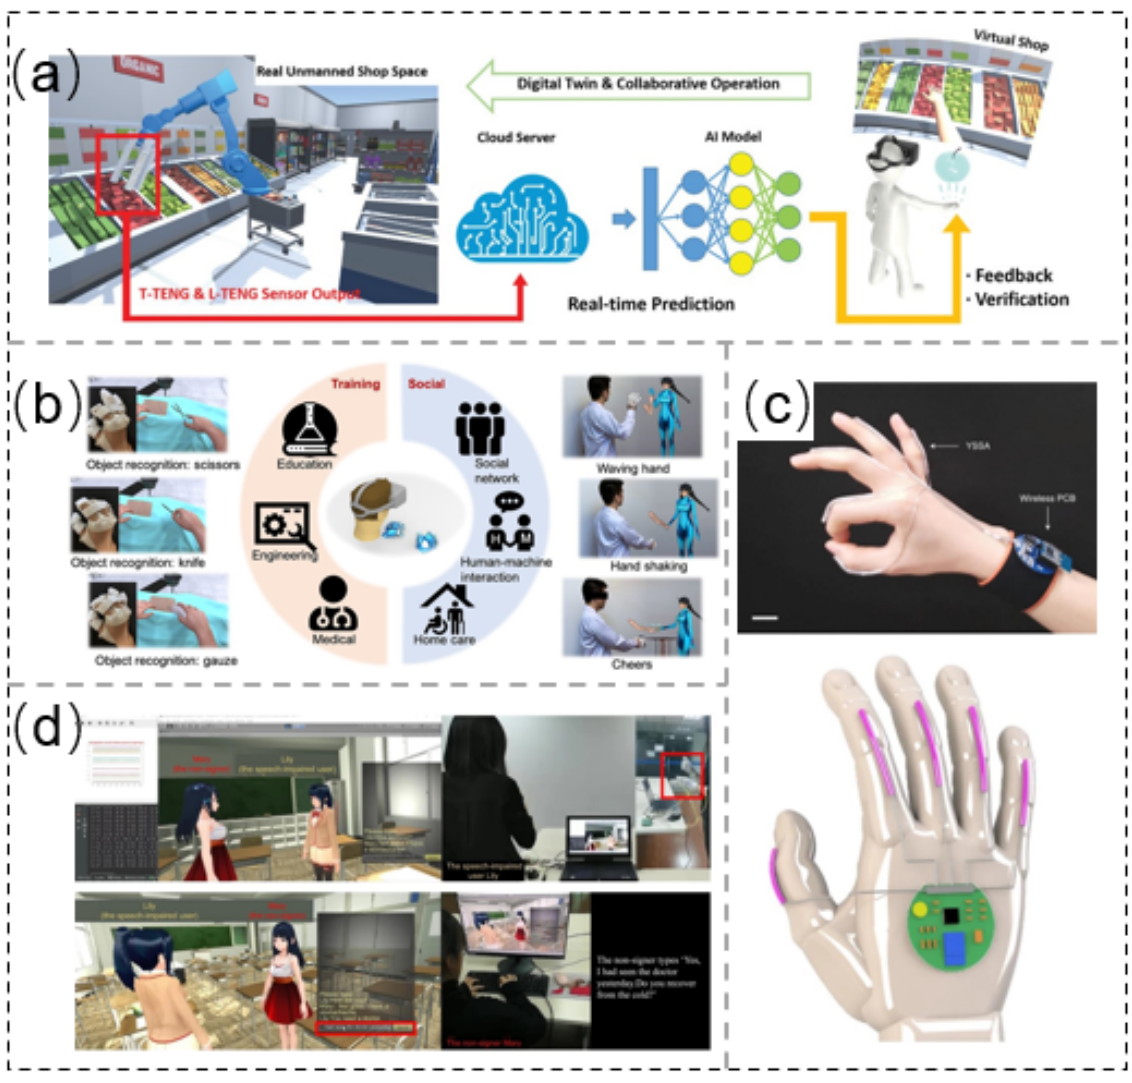
Figure 14. AI applications. ( a ) Photograph of digital-twin-based virtual shop system. Reprinted from Ref. [163]. ( b ) Photograph of various VR training programs and social activities using glove-based HMI. Reprinted from Ref. [164]. ( c ) Photograph of wearable sign-to-speech translation system and real-time display. Reprinted with permission from Ref. [165]. Copyright 2020 Springer. ( d ) Photograph of sign language recognition and communication system. Reprinted from Ref. [166].